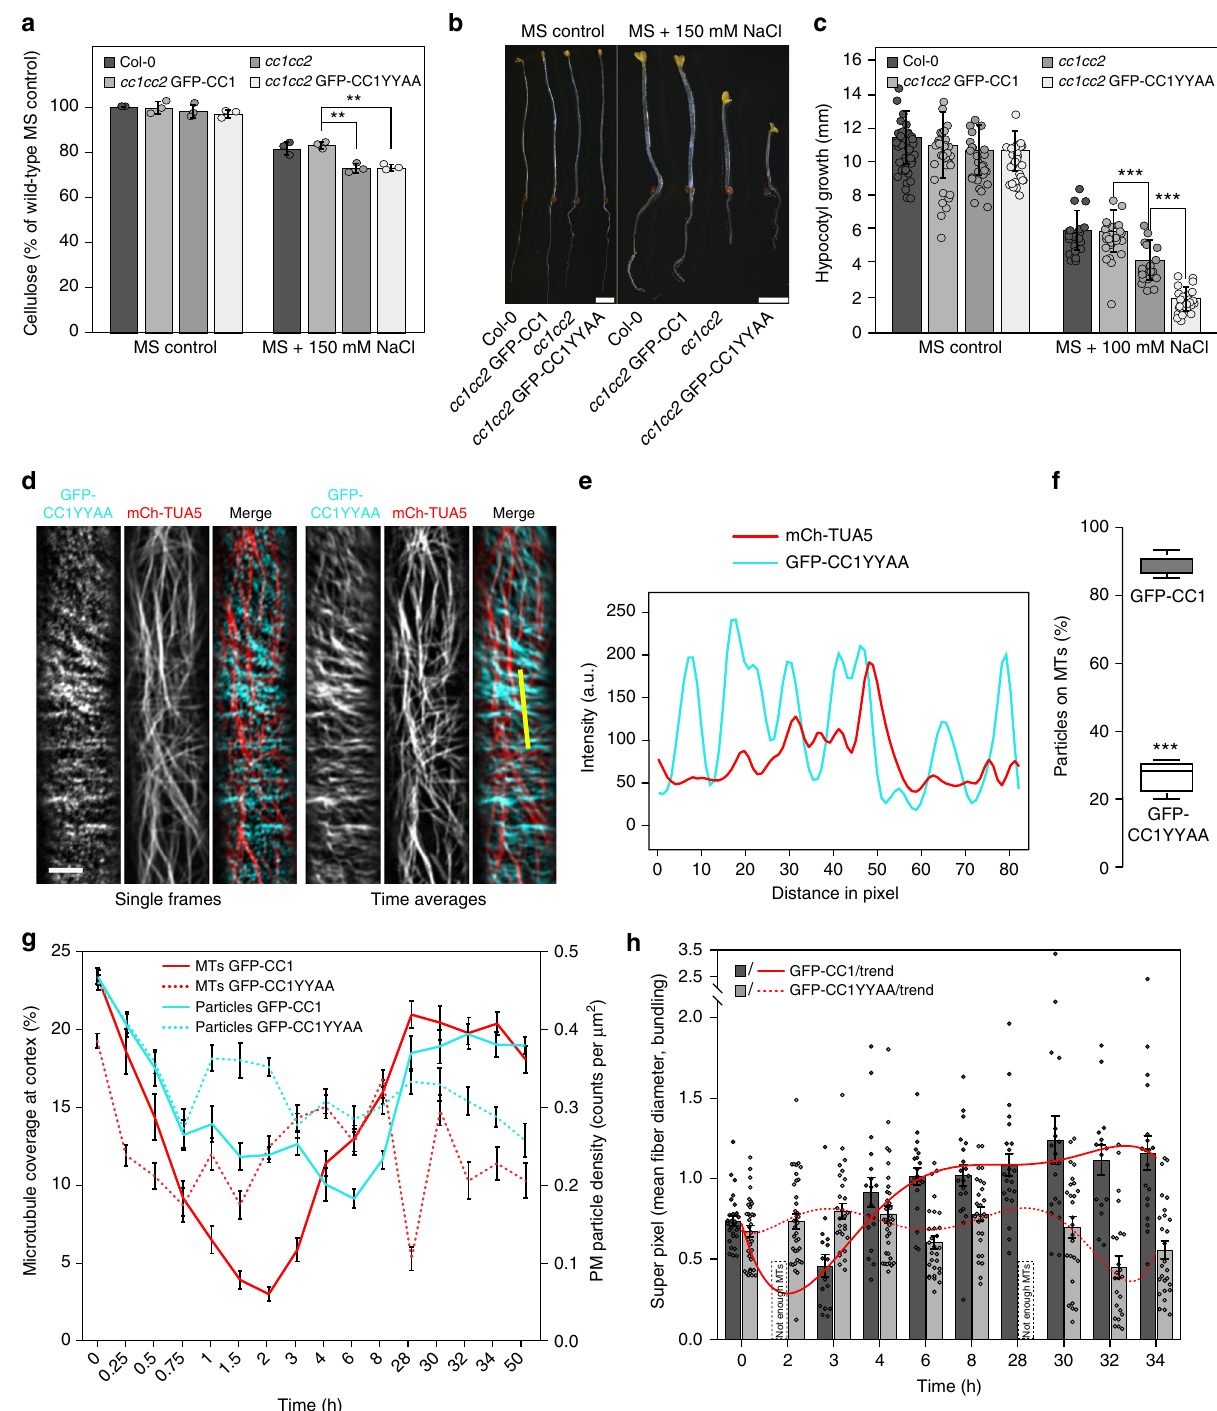
microtubule array and cellulose synthesis were restored within 28 h of salt exposure in the GFP-CC1-complemented cc1cc2 seed- lings (Fig. 5g). However, the cc1cc2 GFP-CC1YYAA- complemented seedlings largely mimicked the cc1cc2 mutant seedlings and failed to restore the microtubule array and cellulose synthesis during the course of the experiment (Fig. 5g). Inter- estingly, while the cc1cc2 GFP-CC1 line showed increased microtubule bundling of the salt-adjusted microtubule array, the cc1cc2 GFP-CC1YYAA cells failed to do so (Fig. 5h). Further- more, the microtubule dynamics differed in the GFP-CC1 and NATURE COMMUNICATIONS| (2019) 10:857